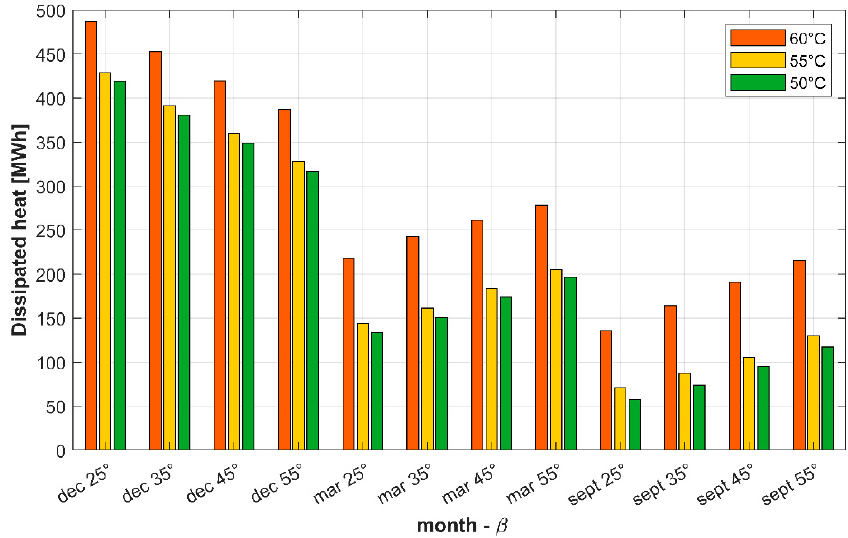
Figure 3. Dissipated heat in the year.